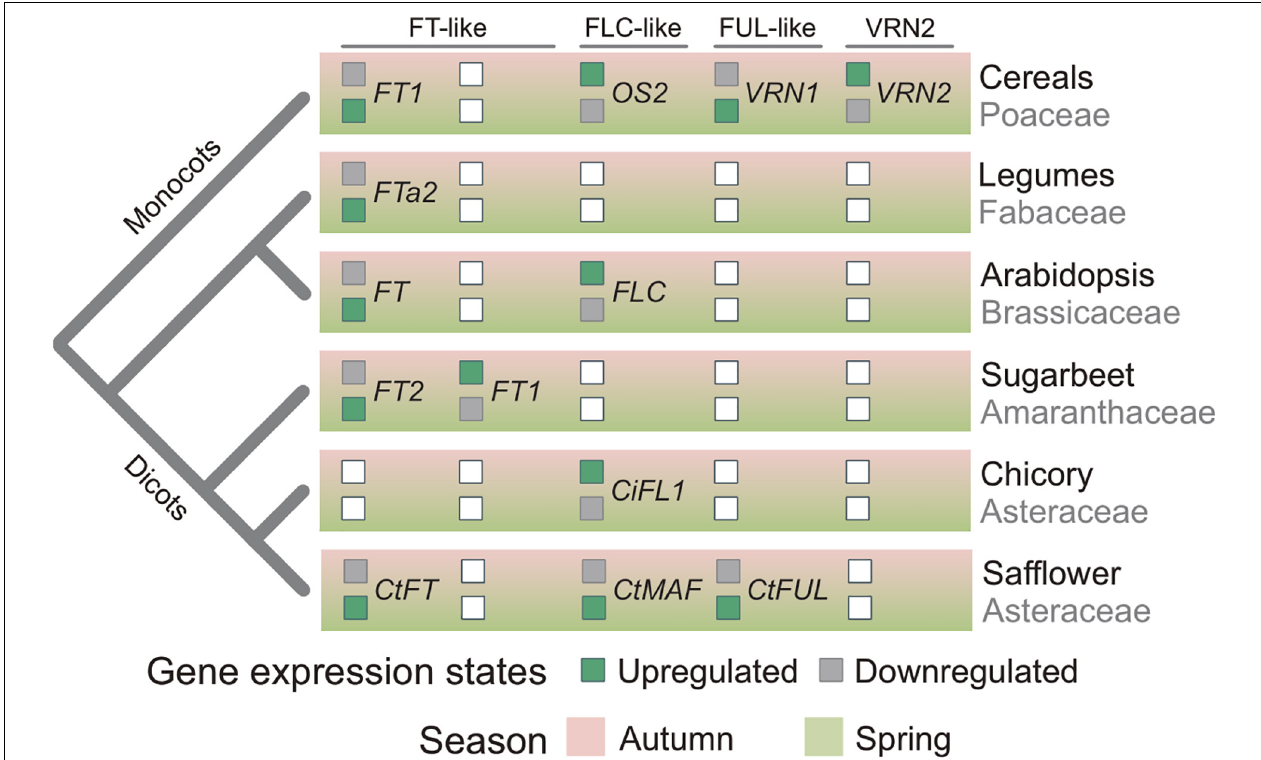
FIGURE 7 | Relationships between phylogeny and seasonal gene expression signatures. Inferred seasonal gene-expression states of flowering regulators in plants related to phylogenetic relationships. Boxes filled green indicates whether a gene is actively expressed in either autumn or spring. Gray filled boxes indicate a gene is repressed in autumn or spring. White box denotes that the gene has not been found in a plant lineage or that the expression state is unknown. CtMAF refers to both CtMAF1 and CtMAF2 , which show similar seasonal gene expression